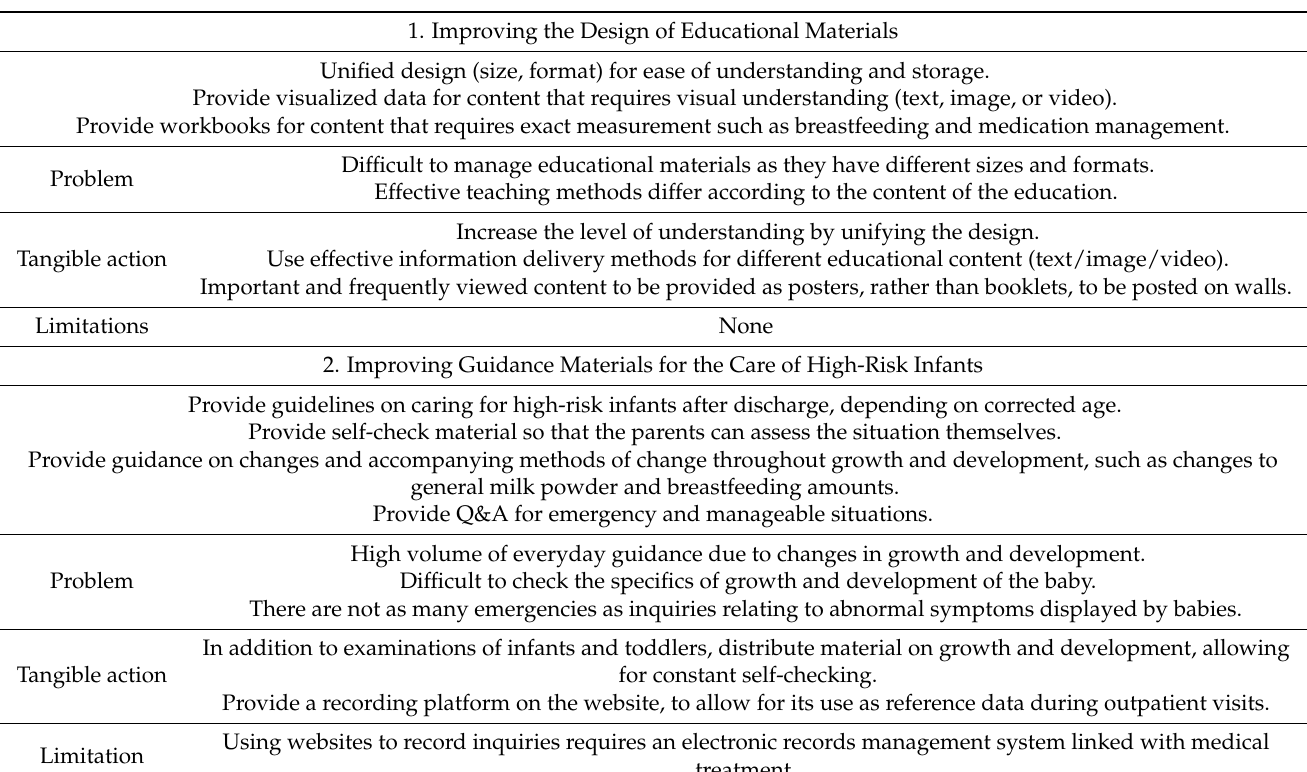
Table 3. Healthcare service design concept (idea–concept